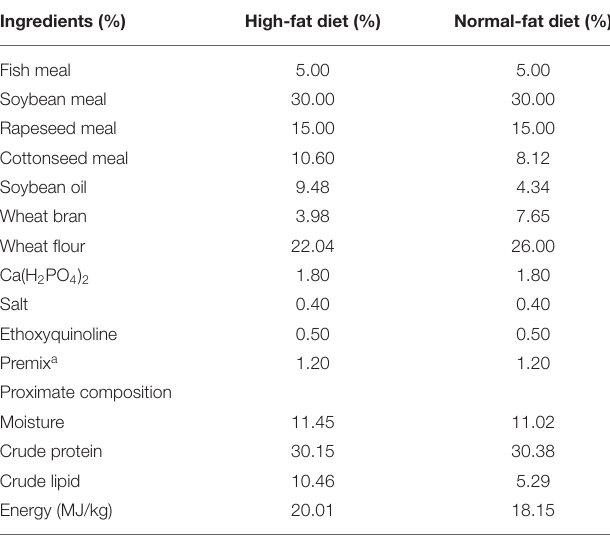
TABLE 1 | Formulation and proximate composition of the experimental